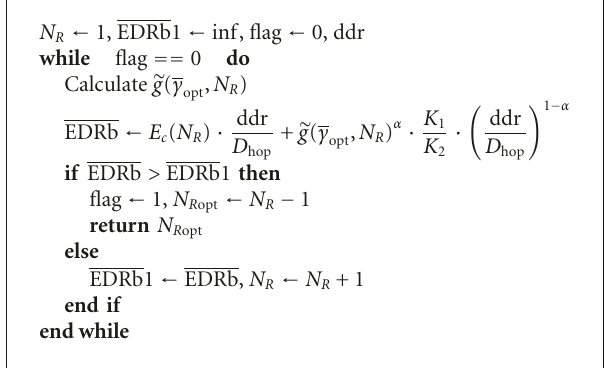
Algorithm 1: Search the optimal number of receivers N Ropt